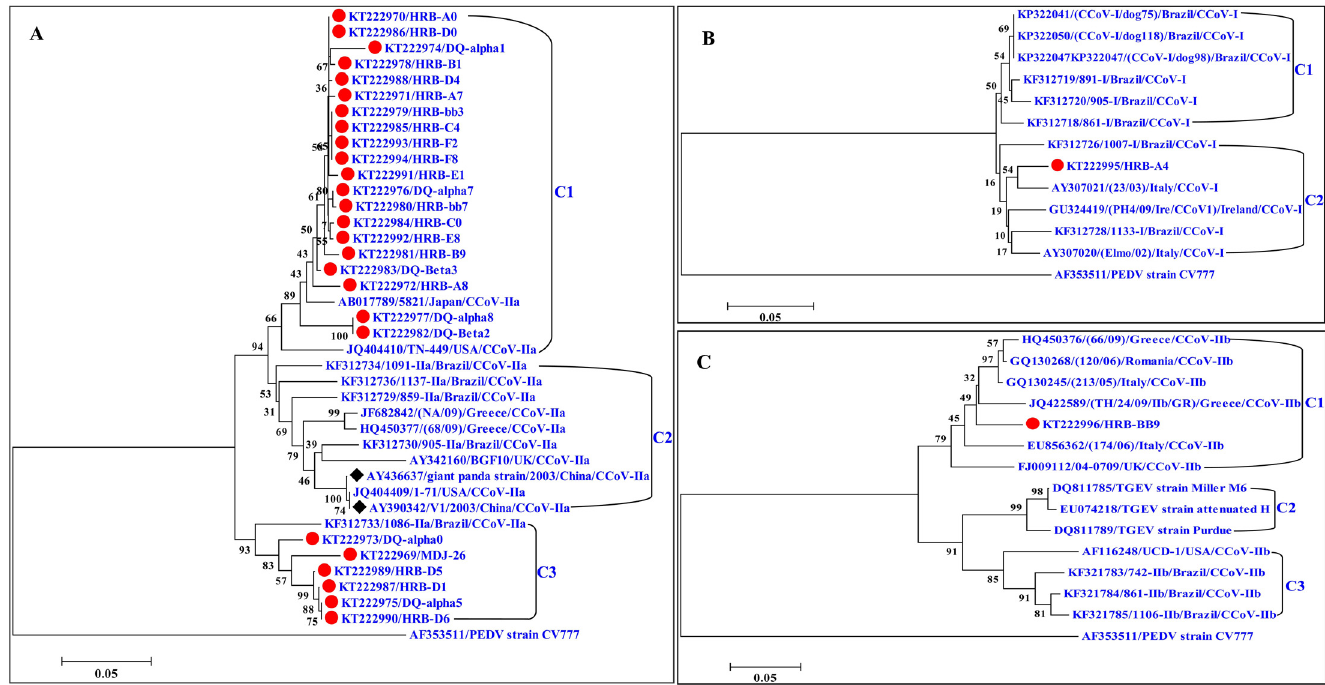
Fig 2. Phylogenetic analysis of CCoV strains on the basis of partial S gene sequences. (A) Phylogenetic tree generated using the nucleotide sequences of the partial S gene of CCoV-IIa. (B) Phylogenetic tree generated using the nucleotide sequences of the partial S gene of CCoV-I. (C) Phylogenetic tree generated using the nucleotide sequences of the partial S gene of CCoV-IIb. Red circles represent the CCoV strains identified in our study.